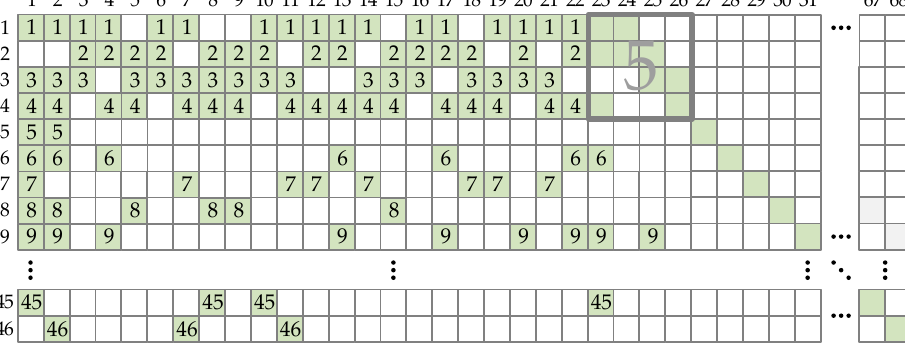
Figure 4. Encoding schedule for BG1 codes when processing the entire base graph matrix row at the same time. Numbers represent the ordinal of the clock cycle in which the corresponding CPM is processed.